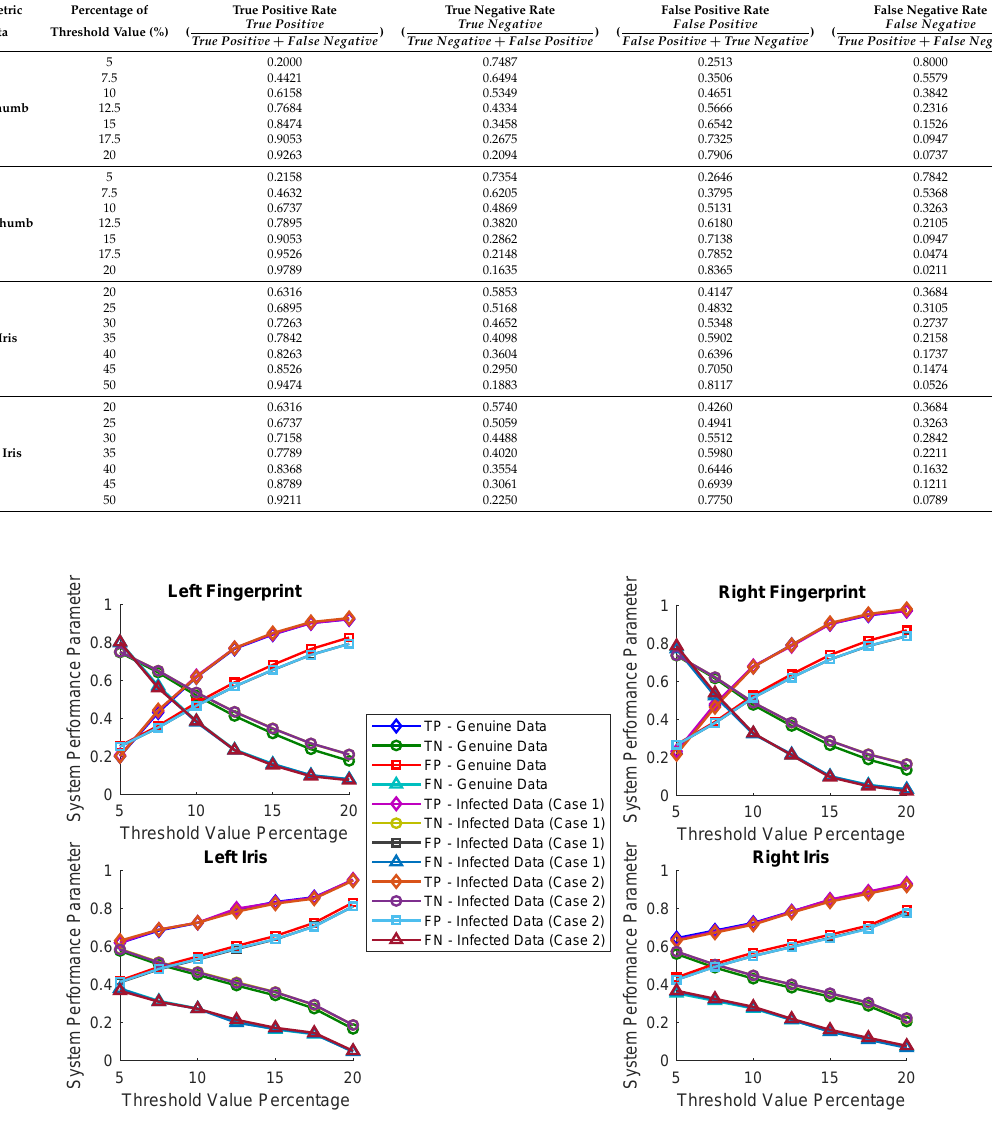
Figure 10. The graphical analysis of the system performance for different biometric